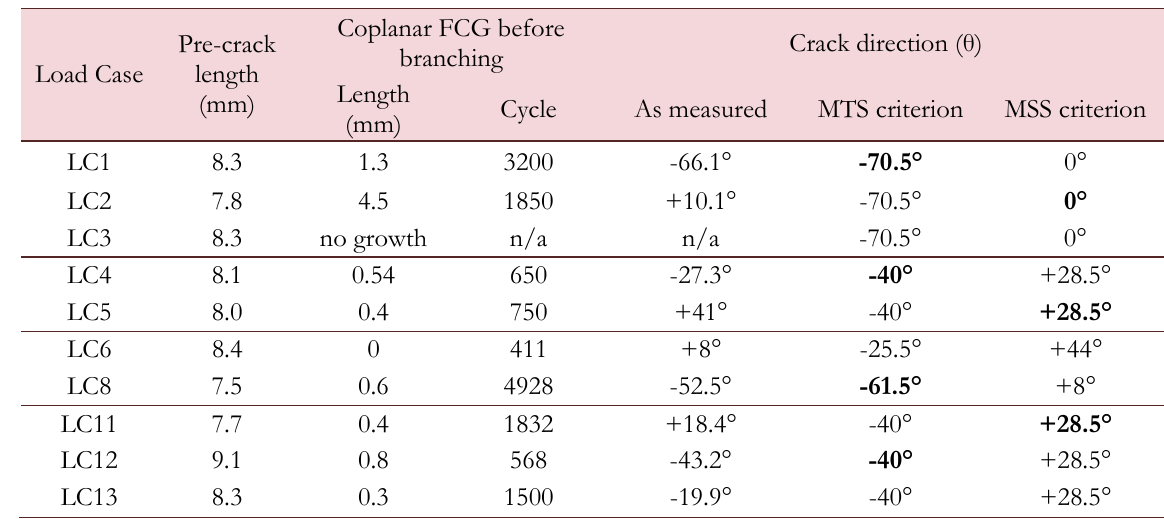
Table 1: Fatigue crack growth behaviour under mixed mode